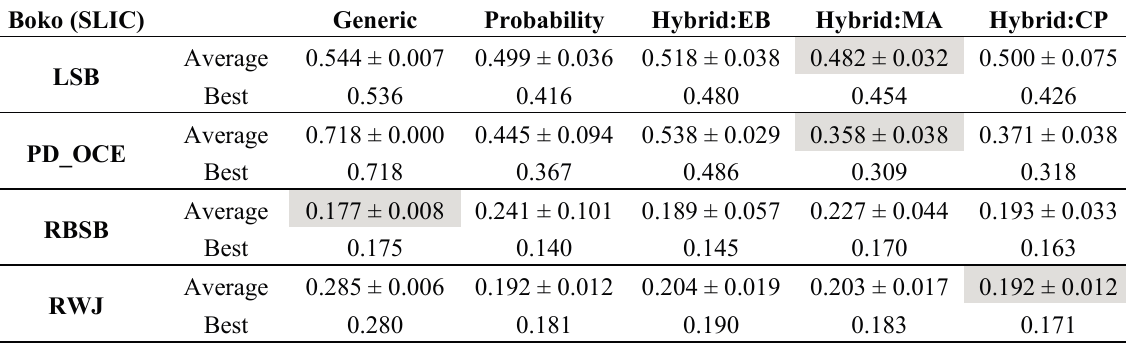
Table 3. Segmentation accuracies achieved in the Bokolmanyo problem instance. The shaded cells highlight the results of the best performing hybridization strategy.